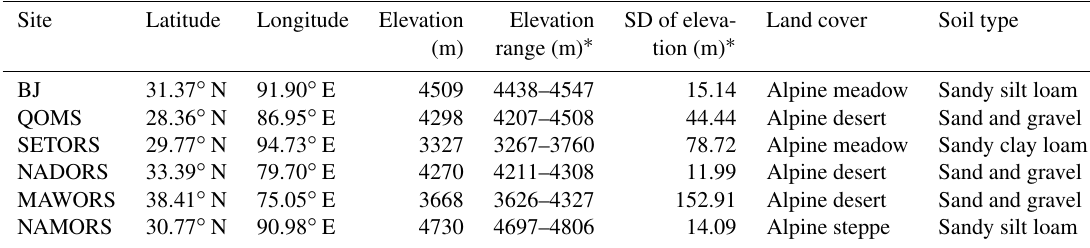
Figure 1. The integrated land–atmosphere observation network on the TP. At each site, the near surface atmospheric conditions are sampled with multilayer wind speed and direction, air temperature and humidity instruments. Surface pressure, precipitation and four-component surface radiation fluxes are also measured. Vertical profiles of soil temperature and soil moisture content are monitored by multilayer tem- perature probes and water content reflectometers. An open path eddy covariance turbulent measurement system is installed at each site to provide continuous monitoring of the vertical turbulent fluxes within the atmospheric boundary layers (the data source of the land cover map in the top of this figure is Ran and Li, 2019). Table 1. List of the geographic characteristics of the six